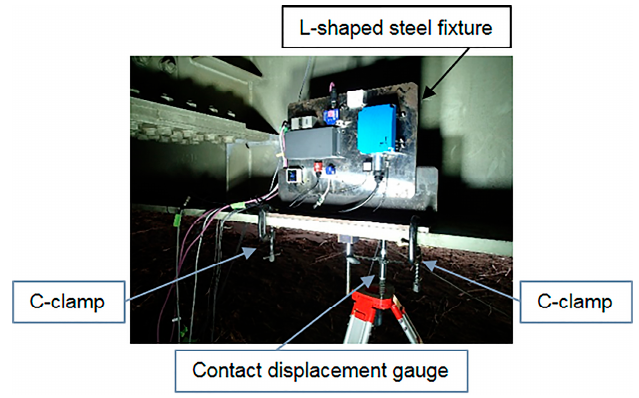
Figure 1. Test bridge used in field measurements (Units: mm).